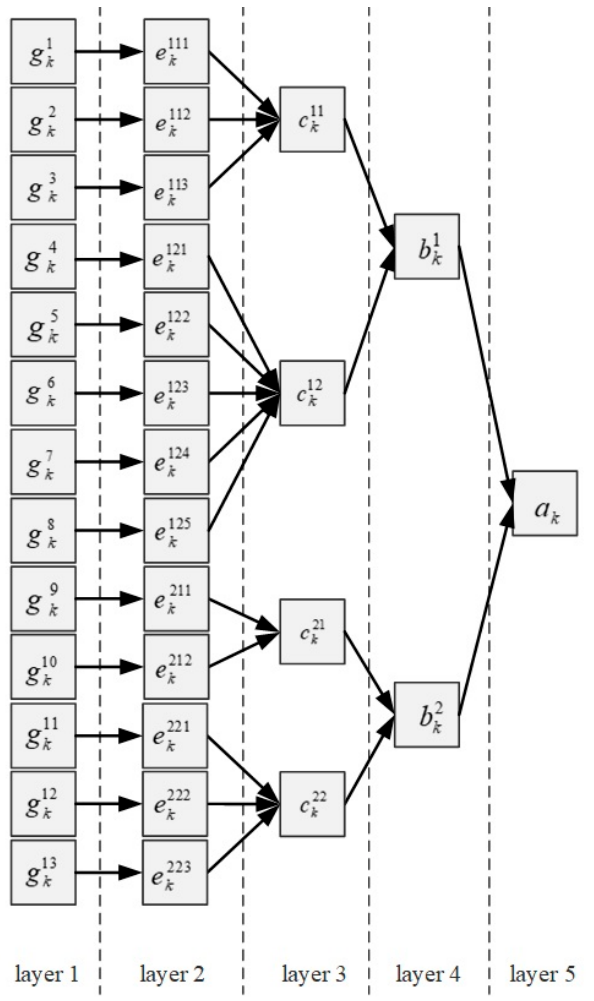
Figure 3. Structure of the composite index of the information society development level.